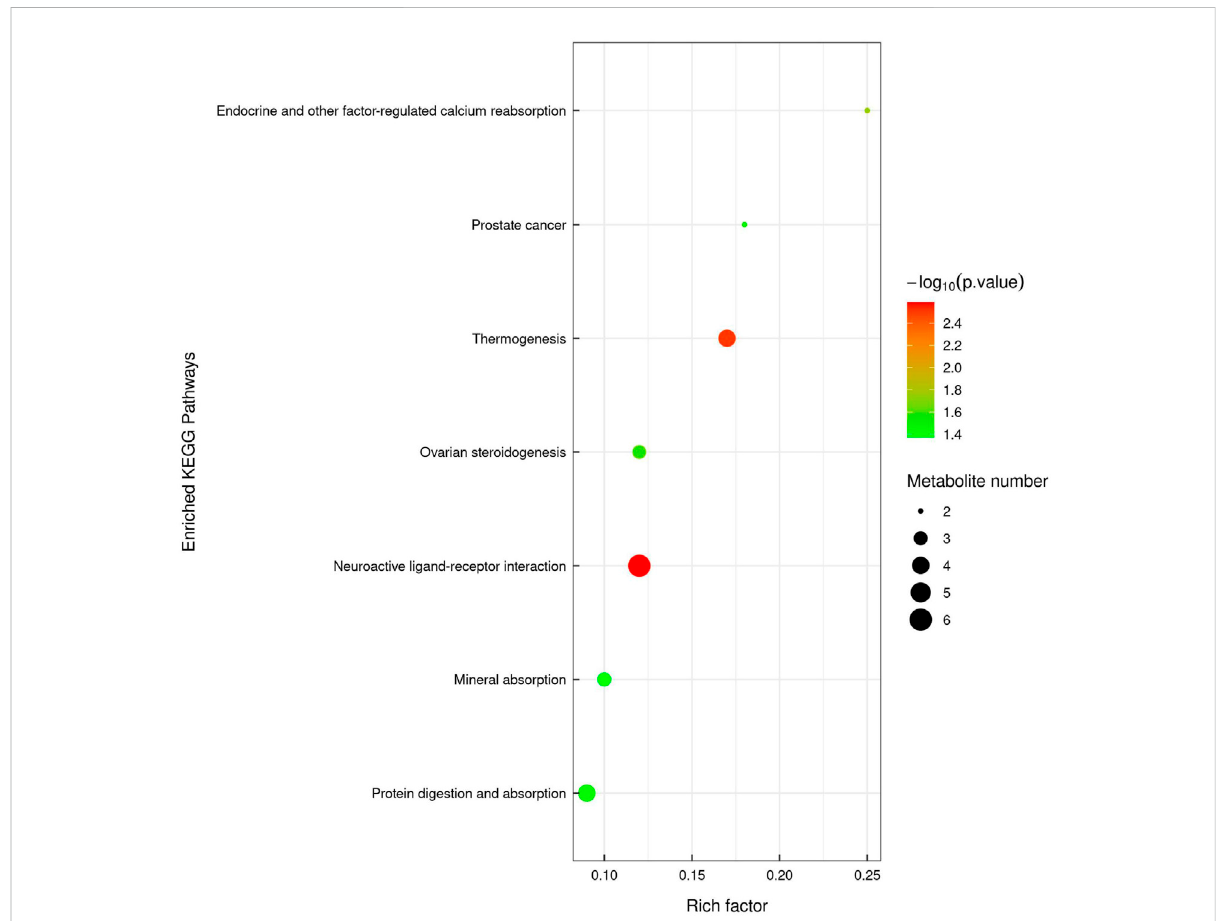
FIGURE 3 KEGGpathwayenrichmentanalysis ofthose 121signi fi cantly changedfecal metabolites. The colorofthe pointrepresented p -valueand itssize indicated the number of different metabolites enriched. The value of rich factor represented the ratio between the number of different metabolites and the total metabolites in each